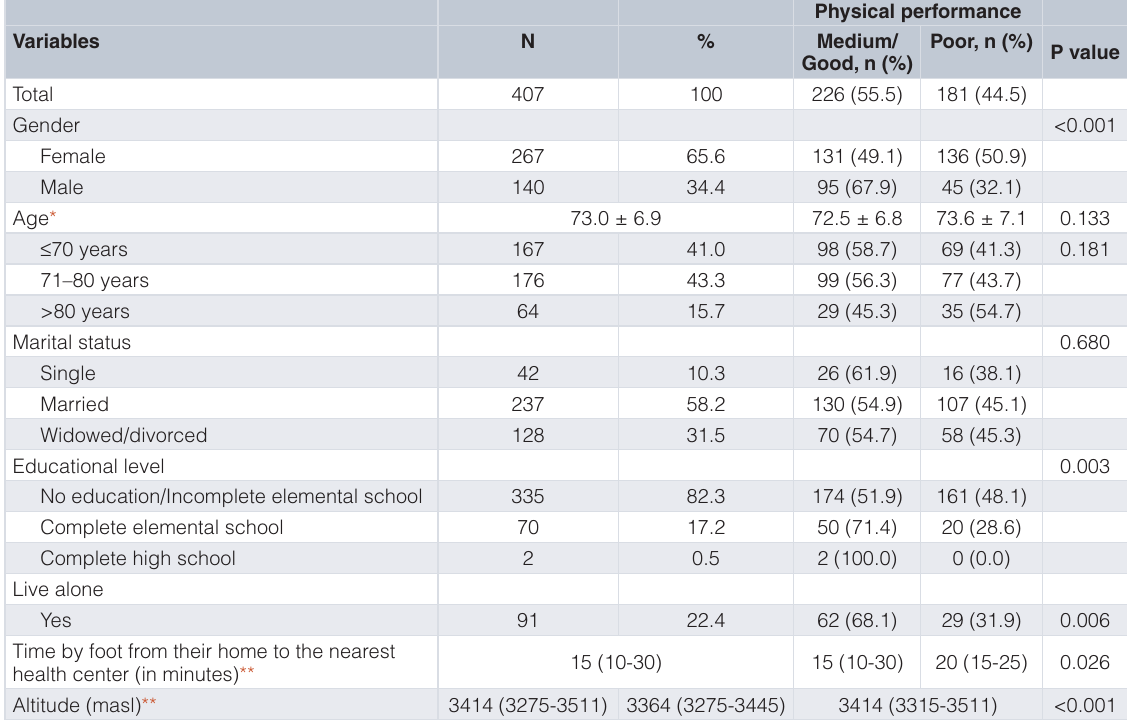
Table 1. Sociodemographic characteristics of the study sample and bivariate